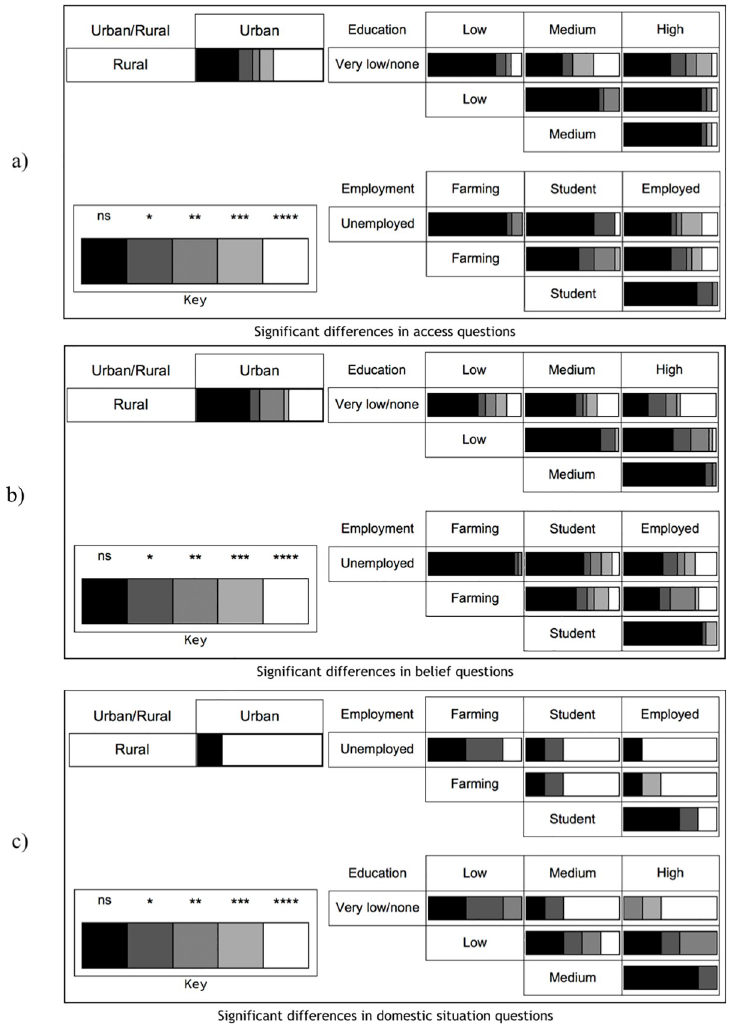
Fig 8. The number of questions for which there were different levels of significance between the SES classes. Horizontal length of shaded block corresponds to the number of questions of that significance level between the particular classes: a) Questions related to access (n = 19), b) to beliefs (n = 25), and c) to the domestic situation (n = 5). For more detailed analyses as well as questions please see S1